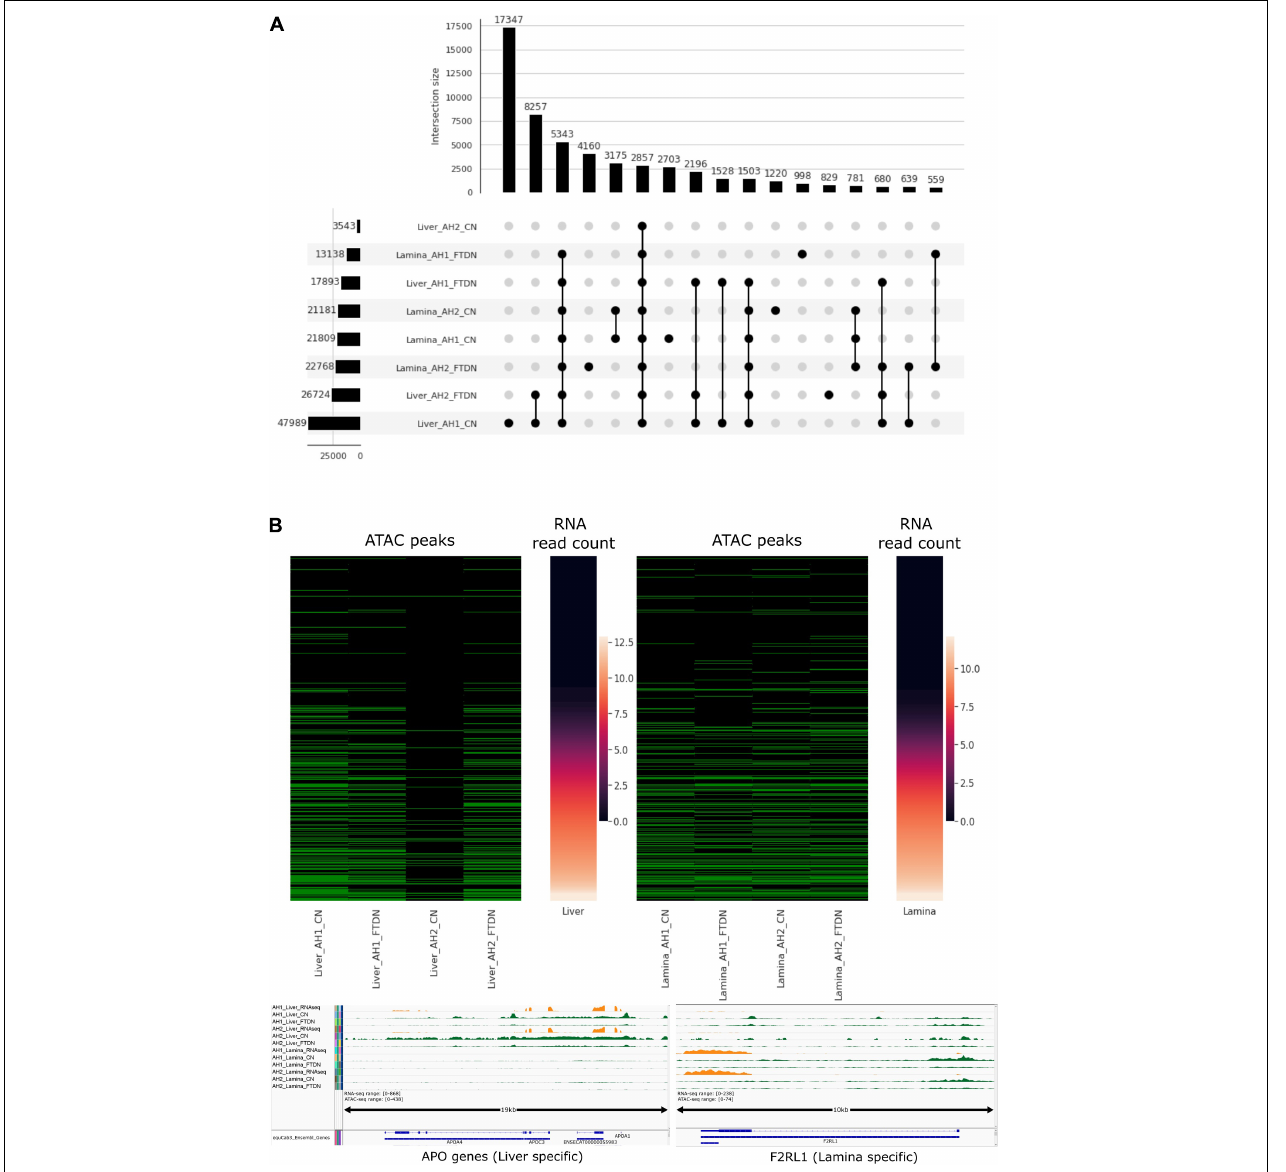
FIGURE 4 | Filtered ATAC-seq peaks. (A) Intersection plot of quality filtered peaks from each library. Bottom left panel shows filtered peak count in each library; bottom right panel shows different intersections (BedTools, 1 bp minimum) of peaks where filled dots indicate presence of peaks in corresponding library; Top panel shows peak count in each intersection. (B) Relationship between promoter accessibility and gene expression (mean vst transformed count) in liver (top left) and lamina (top right). Green cell in ATAC peaks indicate presence of ATAC peaks and black cells indicate absence. Bottom panel shows bigwig tracks of RNA-seq and ATAC-seq read abundance (normalized using RPKM)near APO genes (left, liver specific) and F2RL1 (right, lamina specific) transcription start